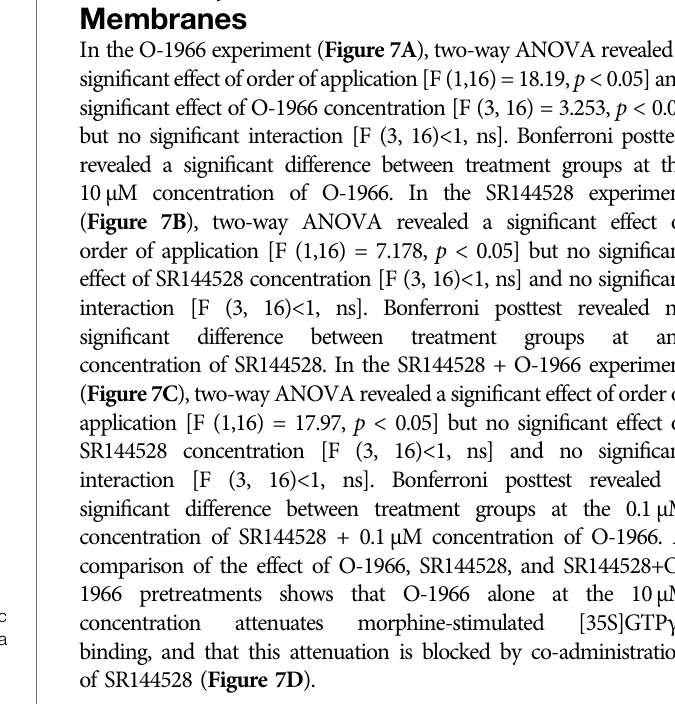
Frontiers in Pharmacology |